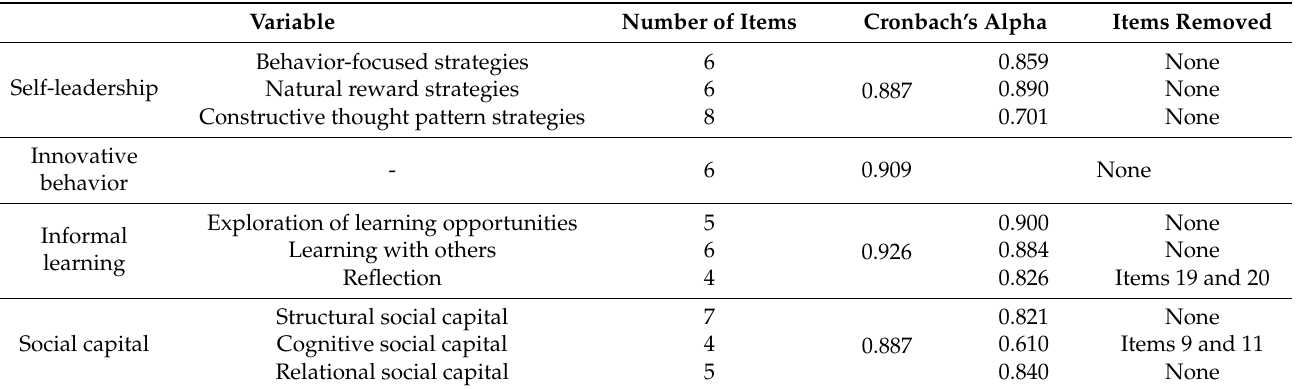
Table 1. Reliability